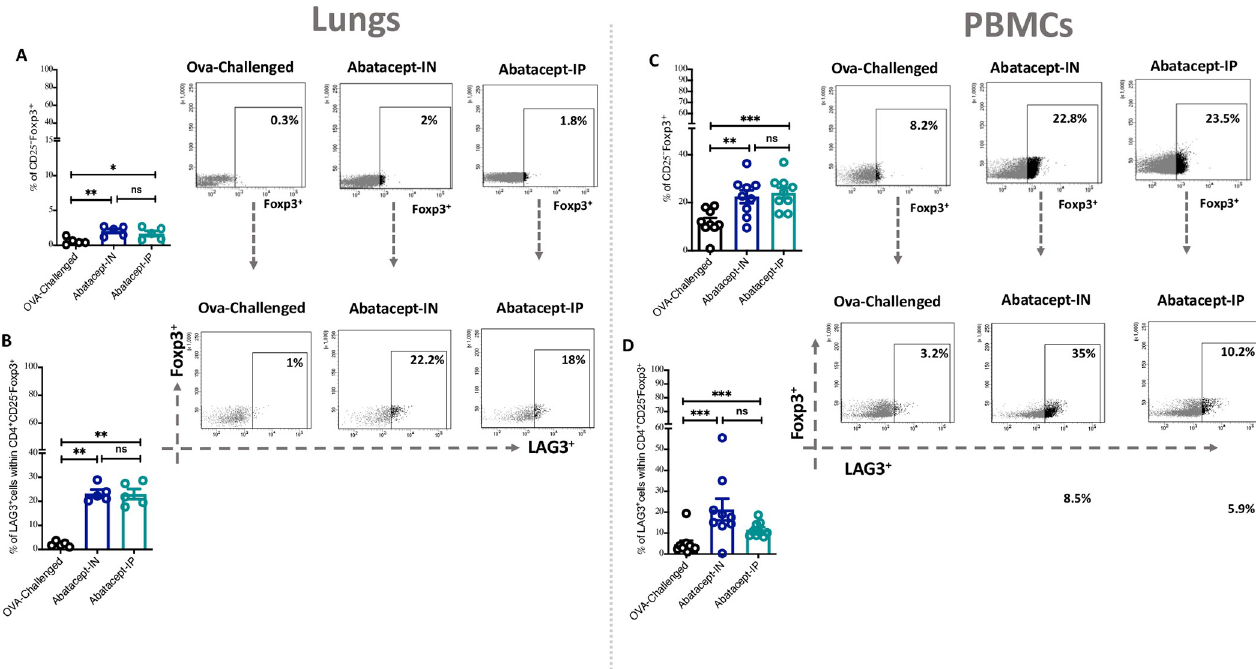
Fig 5. Abatacept enhances the levels of unconventional Tregs (uTregs) in lung tissues and peripheral blood of OVA- sensitized mice. (A) Percentage of uTregs (Foxp3 + cells within CD4 + CD25 - ) in the lung tissues of abatacept IN, abatacept IP treated, or OVA challenged mice. (B) Percentage of LAG3 + uTregs (CD25 - Foxp3 + LAG3 + ) in the lung tissues of abatacept IN, abatacept IP treated, or OVA challenged mice. (C) Percentage of uTregs in the PBMCs of abatacept IN, abatacept IP treated, or OVA challenged mice. (D) Percentage of LAG3 + uTregs in the lung tissues of abatacept IN, abatacept IP treated, or OVA challenged mice. Lung tissues of 5 mice and PBMCs of 10 mice were used. Two-way unpaired t-test was used to calculate significance. ���� P < 0.001. Events were recorded and analysed by using BD FACSDiva version 8.0.